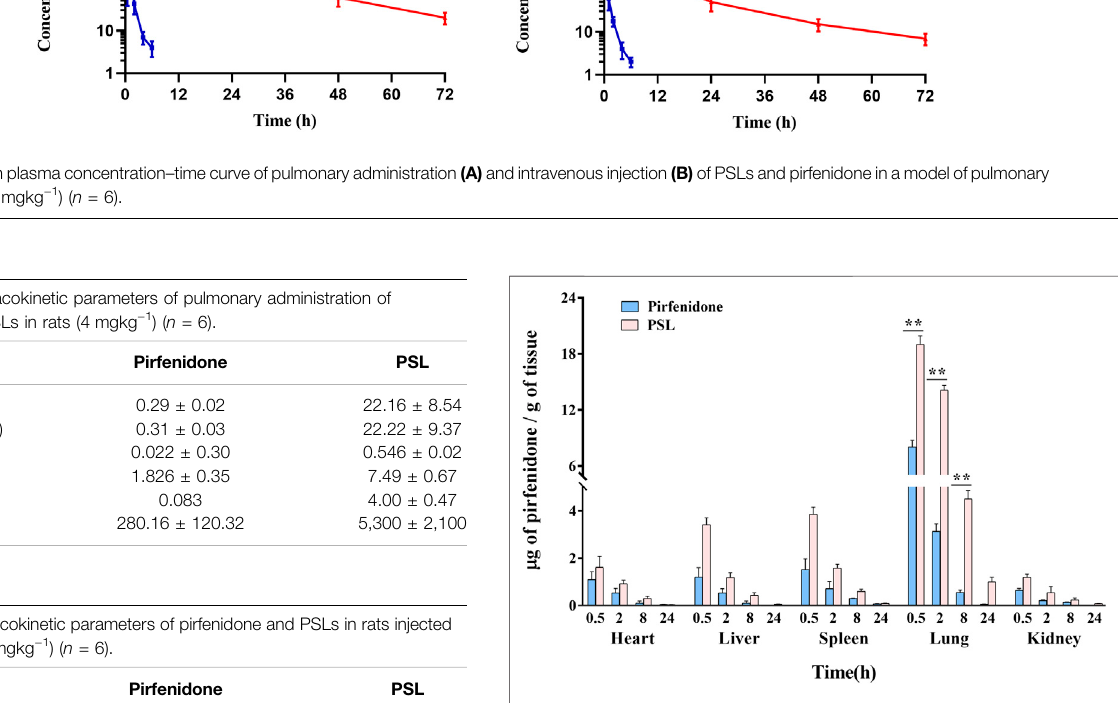
FIGURE7| Pirfenidonelevelintheheart,liver,spleen,lungandkidneyof rats with pulmonary fi brosis after administration to the pulmonary